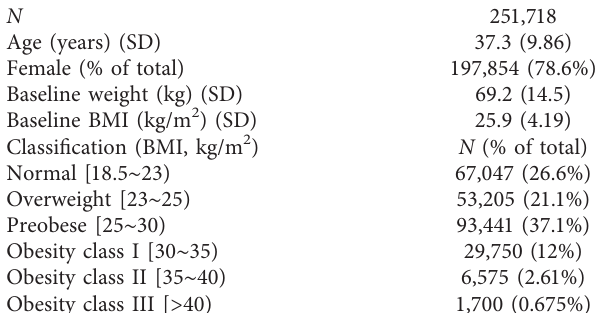
Figure 2: Screenshots of the MetaWell mobile application. (a) Home screen of the application. (b) Weighing screen, shown as users are on scale. (c) Health summary screen. (d) Record of weight change. Table 1: Baseline characteristics of the application